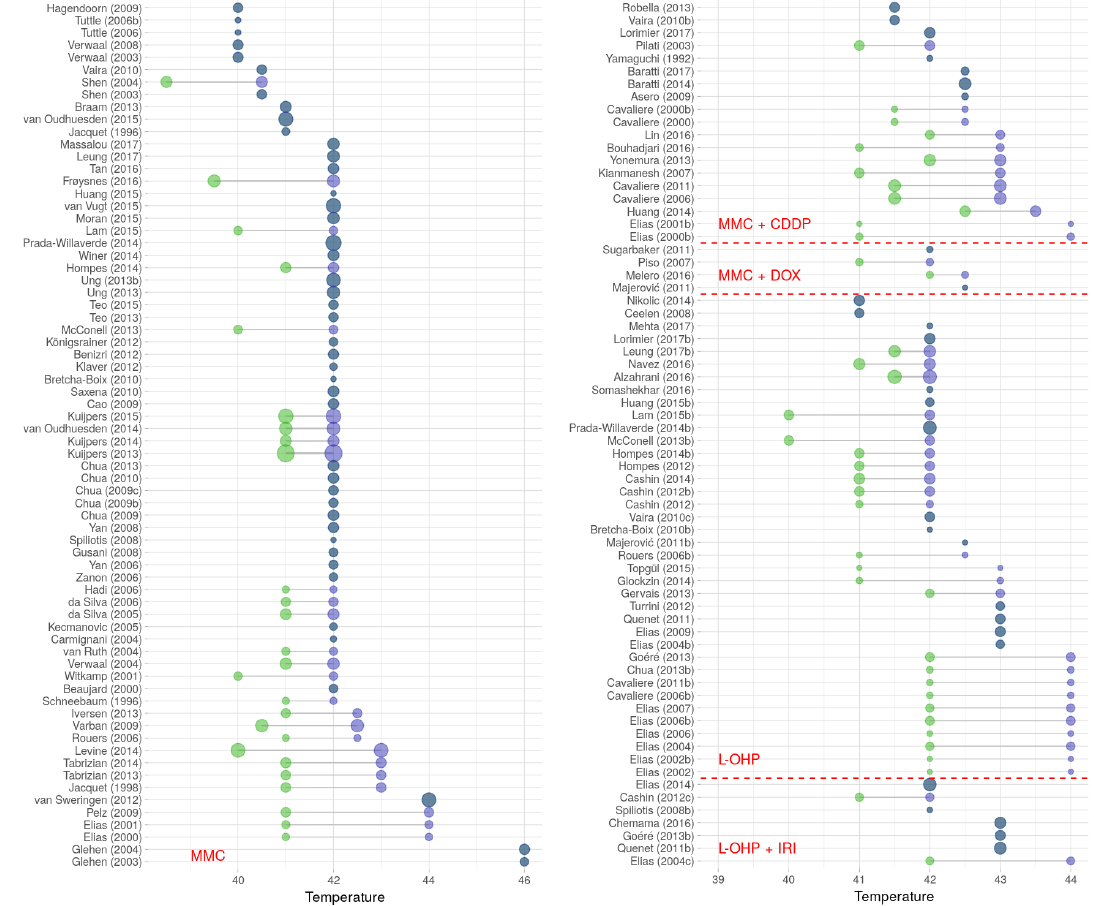
Figure 13. Temperatures during HIPEC: The Lollipop plot depicts temperatures (in ◦ C) reported for HIPEC protocols described in the literature (only reports with n > 4 patients and protocols containing MMC or L-OHP single drug or in combinations were included; temperatures ≥ 46 ◦ C were assigned 46 ◦ C). Green dots signify minimum temperature and purple dots maximum temperatures in case a range was reported. Symbols are lg scaled according to number of patients included.